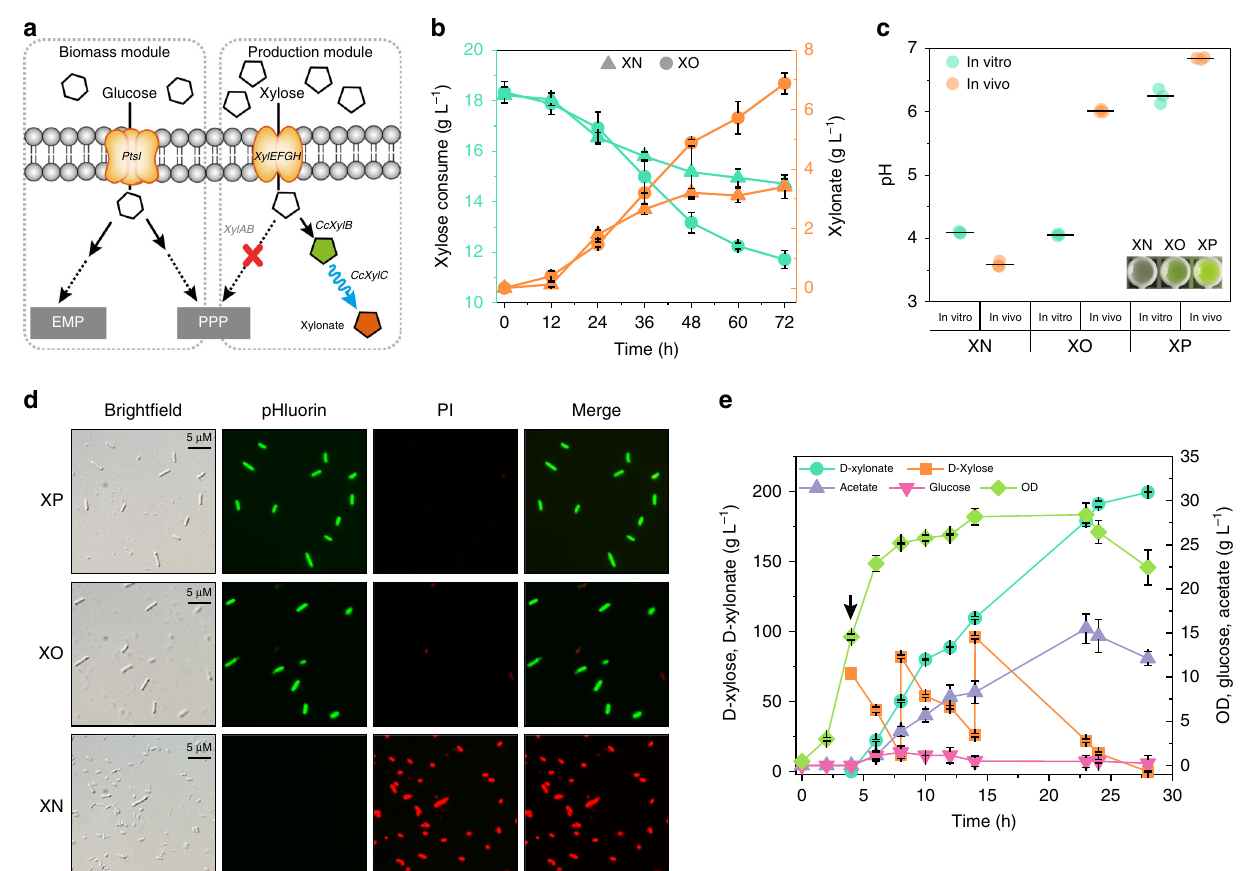
Fig. 7 Application of pbO in D -xylonate production. a D -Xylonate metabolic pathways in E. coli with pbO. Red cross denotes gene disruption. Wavy line denotes metabolic fl ux was periodical slowed down. b Time course of strain XN (solid triangles) and XO (solid circles) in xylose consumption and xylonate production. c The comparison of in vivo and in vitro pH value between different strains. XO, strains with oscillator; XN, strains without oscillator; XP, strains with xylose dehydrogenase but without lactonase overexpression. Insert: photograph of samples from strain XN, XO, and XP. d A series of microscopy images of different strains in xylonate production (48 h). e D -xylonate production of strain XO in 5 L bioreactor. Black arrow indicates induction start time. Values are shown as mean ± SD ( n = 3). CCR, carbon catabolite repression; CcxylC, C. crescentus D -xylono-lactone lactonase; PI, propidium iodide dye. Source data of Fig. 7b-e are provided in Source Data fi